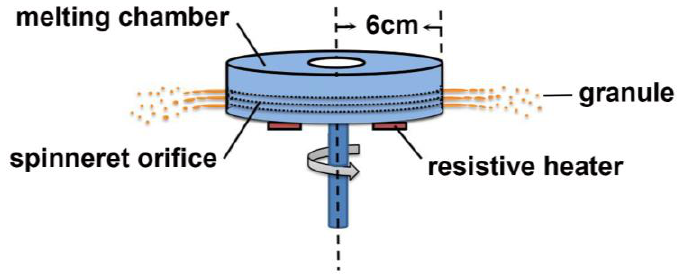
Figure 1. Illustration of the granulation process via melt centrifugal atomization (MCA).